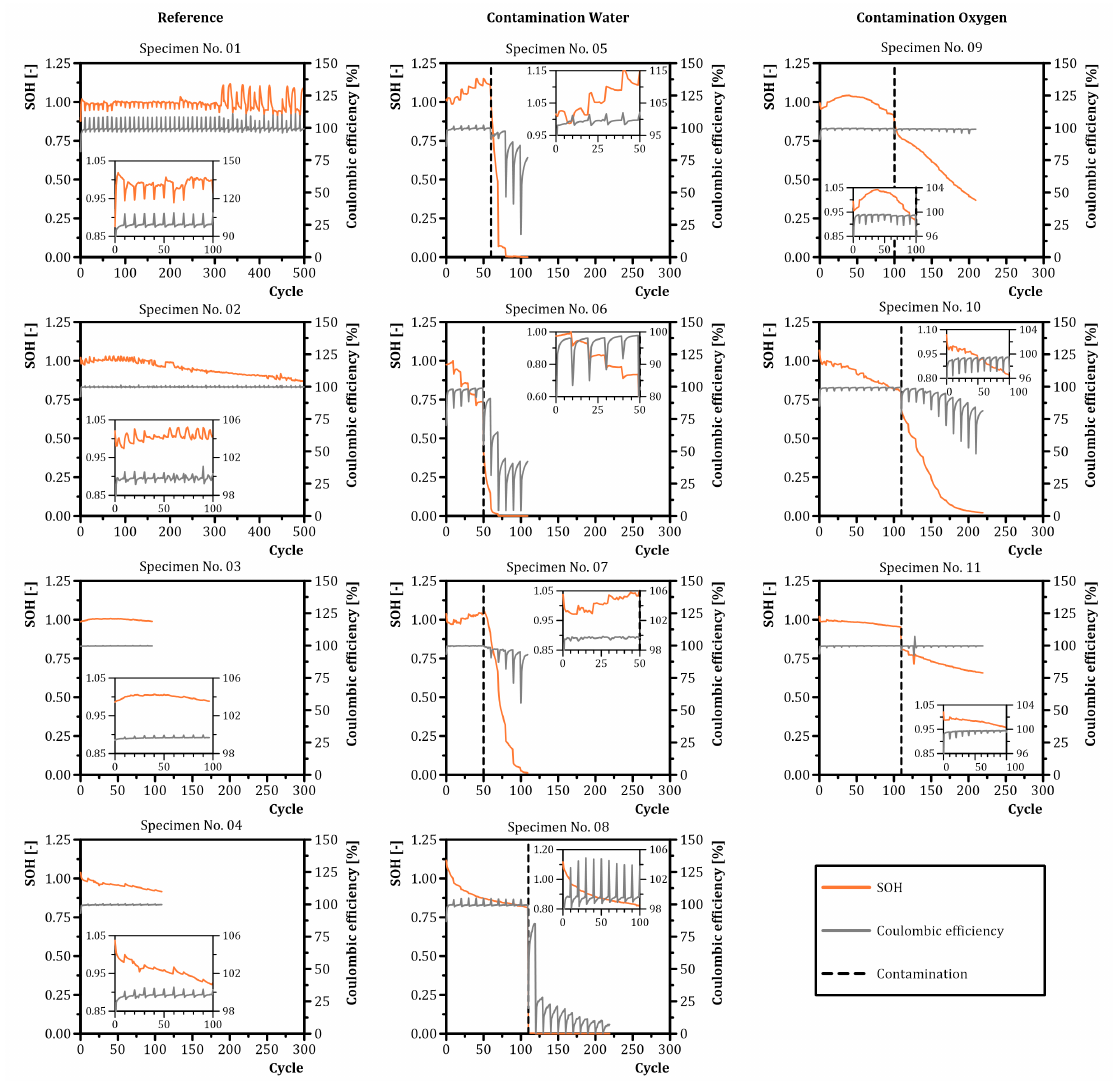
Figure 6. State of health (SOH) and Coulombic efficiency over the number of cycles for different contamination types. First column—reference specimens. Second column—specimens with water contamination. Third column—specimens with oxygen contamination. Dashed vertical lines indicate the contamination initiation